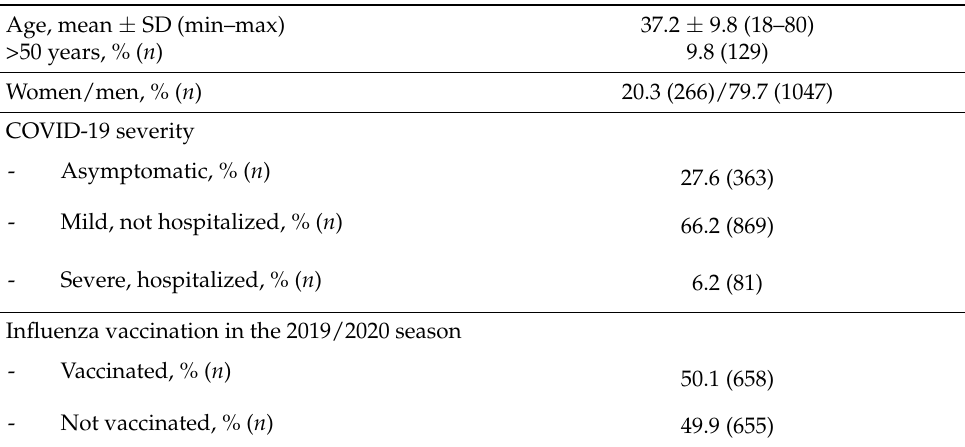
Table 1. Demographic characteristics of the studied group of patients ( n = 1313) whose serum samples were used in the